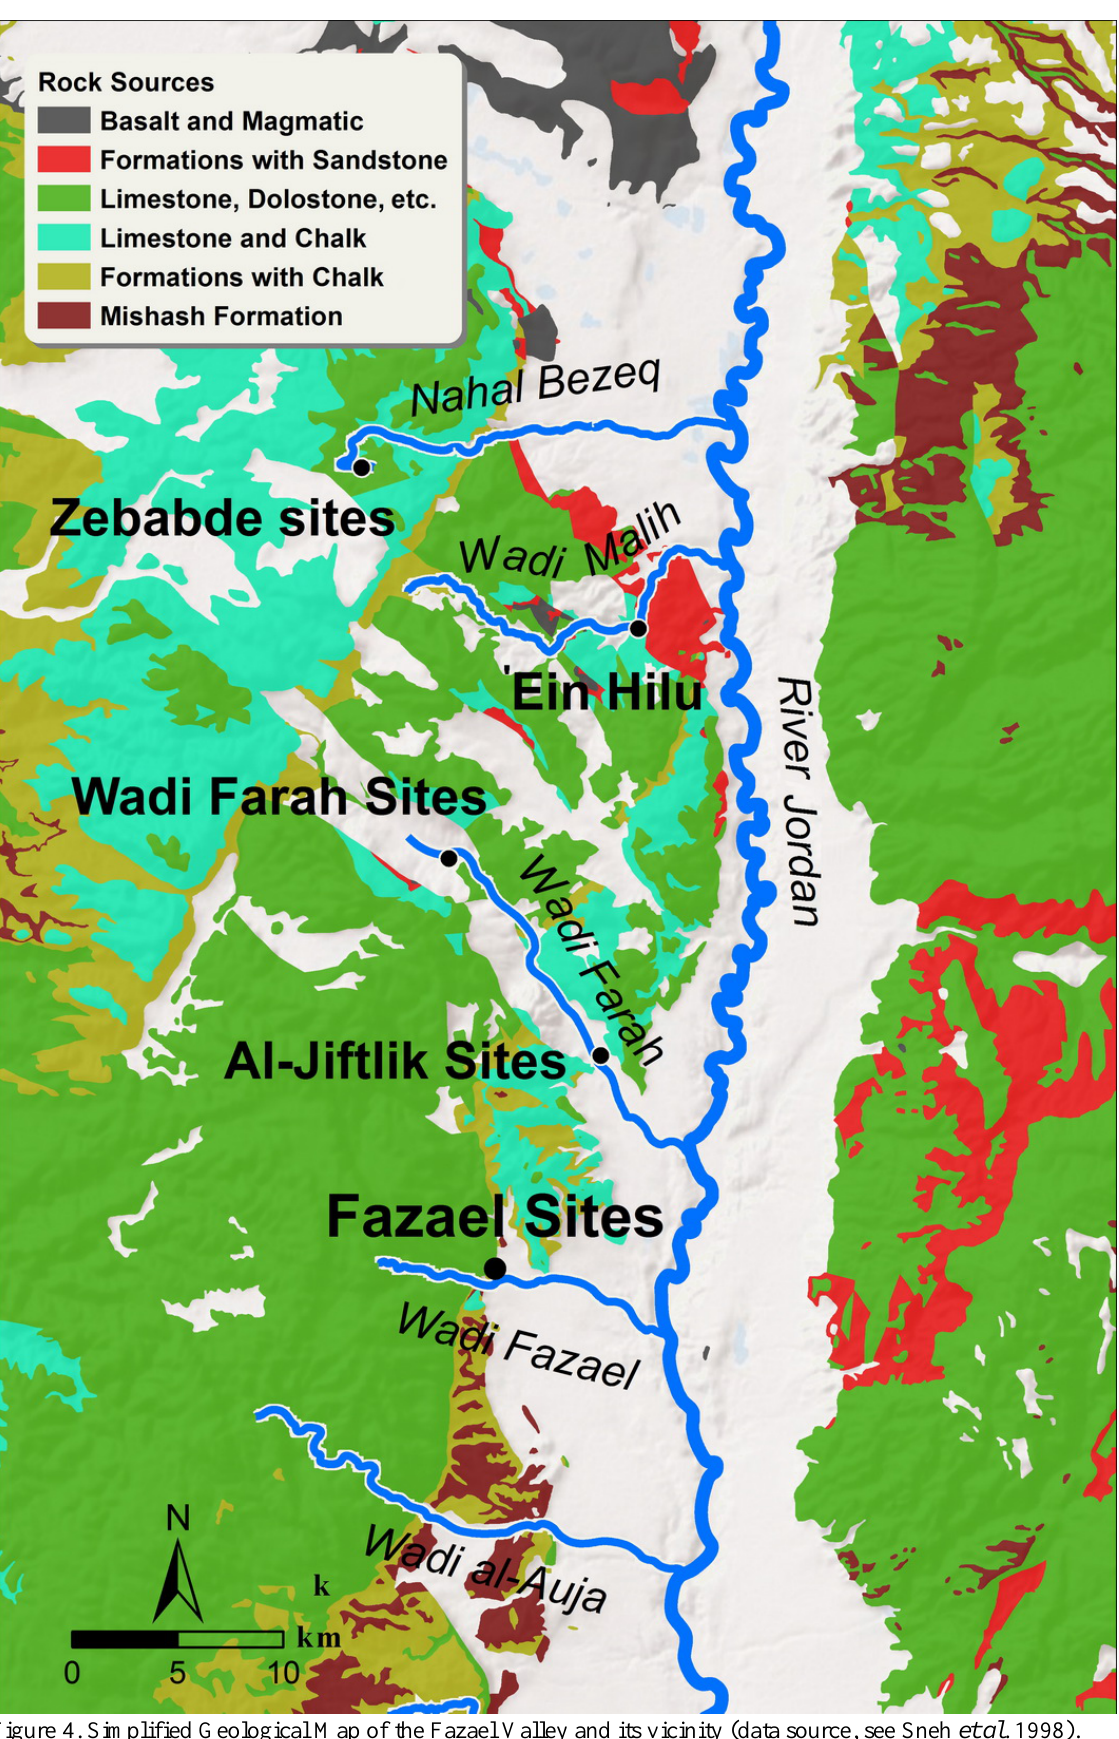
Figure 4. Simplified Geological Map of the Fazael Valley and its vicinity (data source, see Sneh et al .